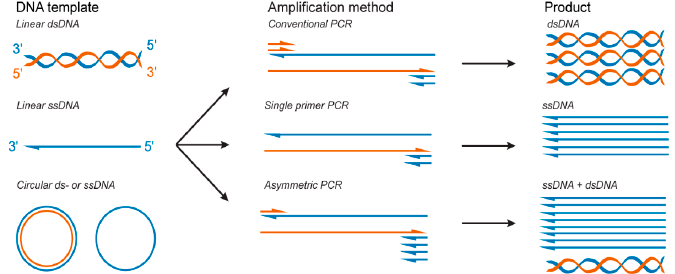
Figure 3. PCR-based methods to produce double-stranded DNA (dsDNA) and ssDNA.